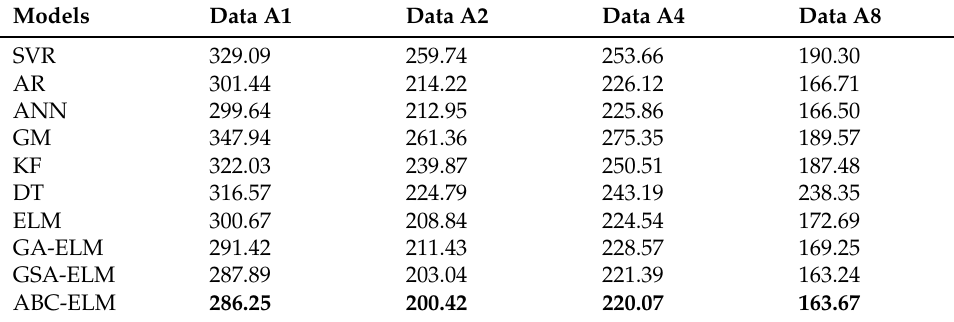
Table 4. The RMSE (vehs/h) of different forecasting models under four datasets.